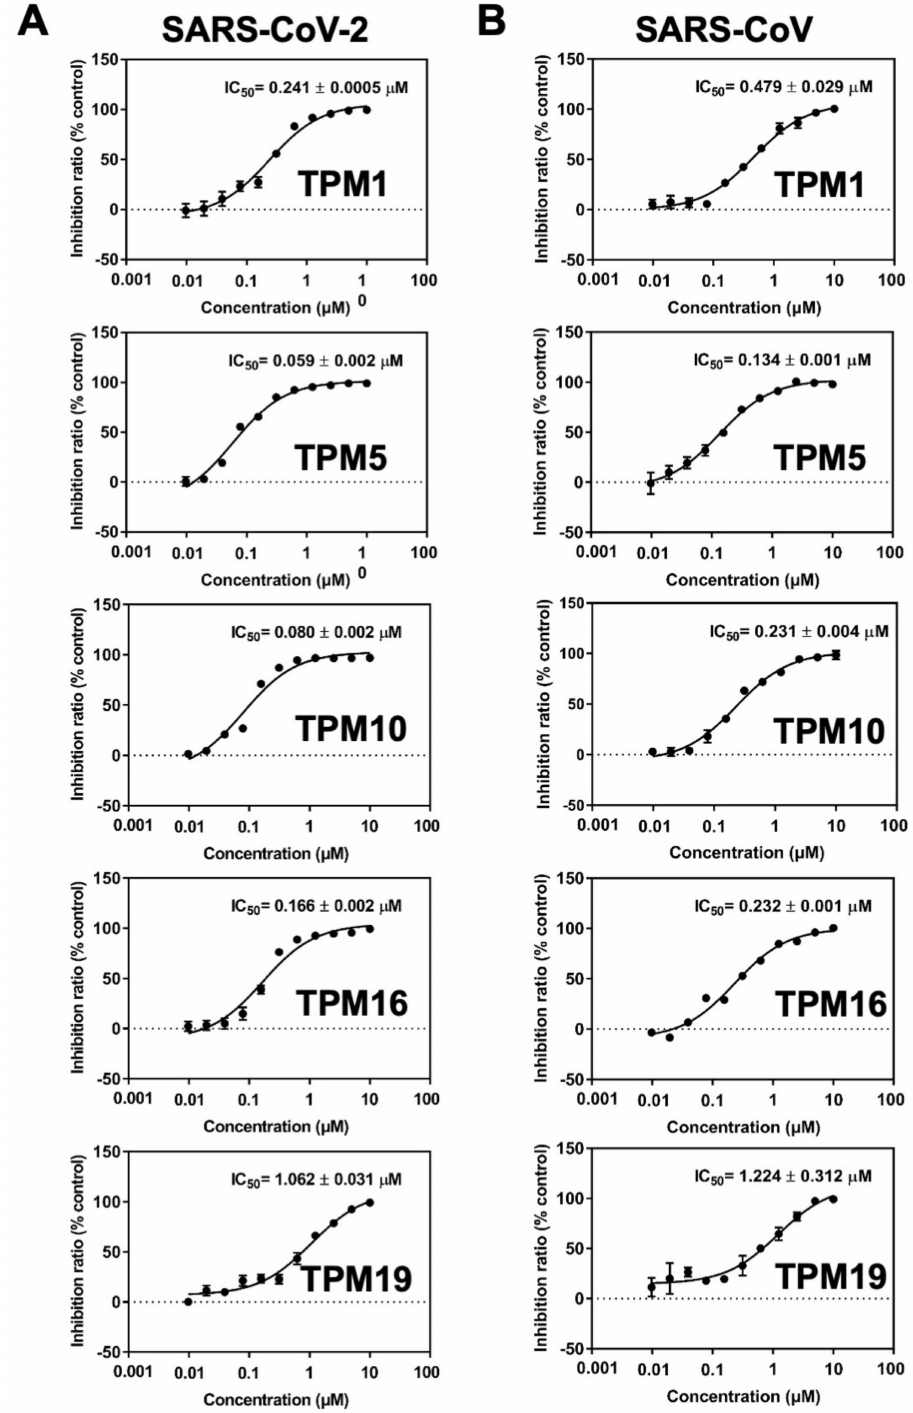
Figure 6. Dose–response curves of TPMs in the 3CL Pro enzymatic activity assays. IC 50 of inhibitors on SARS-CoV-2 ( A ) and SARS-CoV ( B ) 3CL Pro . From top to bottom: TPM1, TPM5, TPM10, TPM16, and TPM19. The TPM’s mediated inhibition was measured for both SARS-CoV-2 and SARS-CoV 3CL Pro . Bars depict the mean ± SE, n =